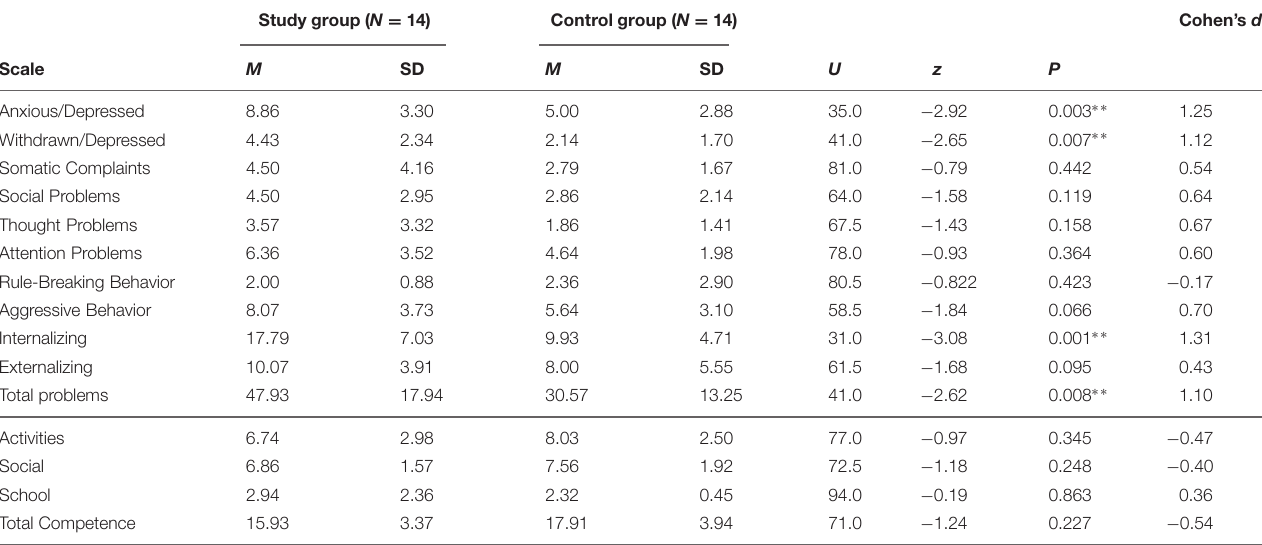
TABLE 3 | Comparison of emotional and behavioral problems and competences (YSR) between children with and without a parent suffering from ALS. Study group ( N = 14) Control group ( N = 14) Cohen’s d